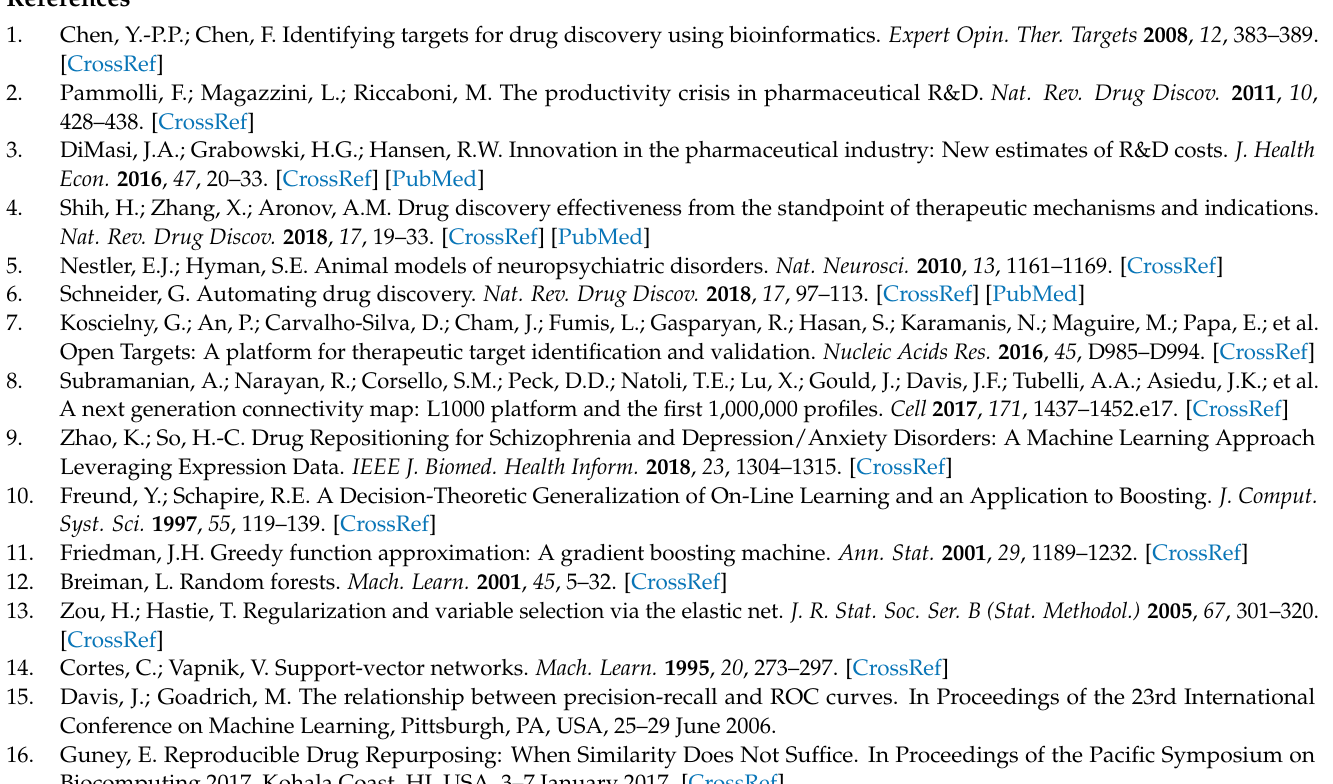
Table S5: Enrichment test of the predicted targets for HT and RA, Table S6: Enrichment test results from Knockdown (KD) data (including 5 sub-tables), Table S7: List of identified targets (the 10 targets with the highest and lowest predicted probabilities of treatment potential are shown; including four sub-tables showing targets for each